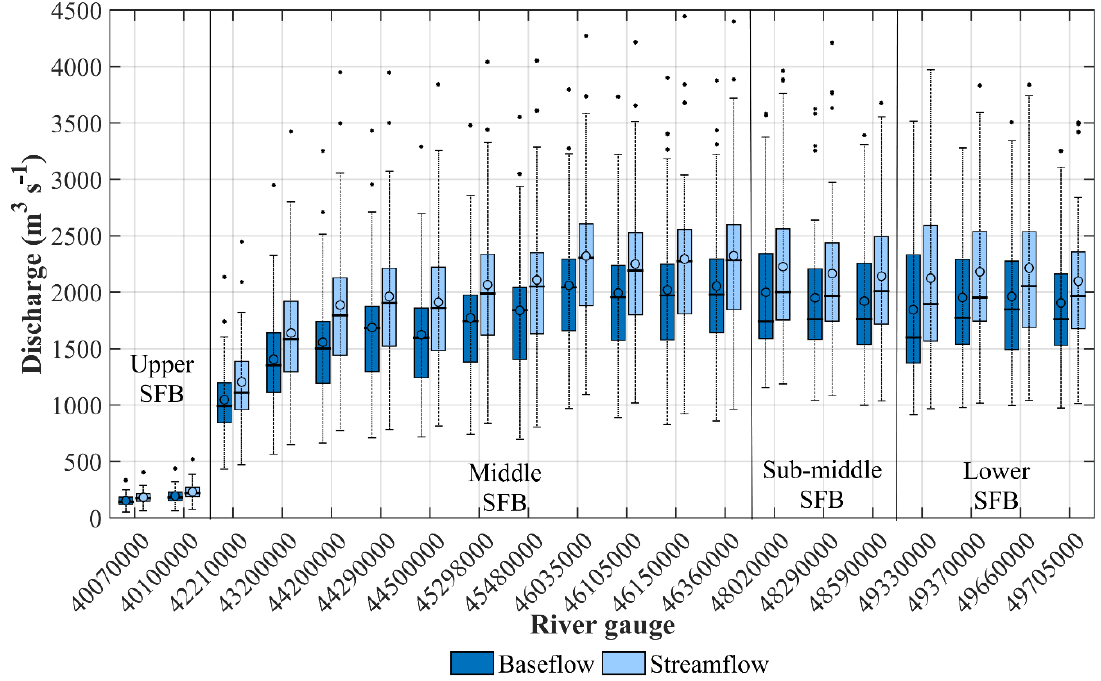
Figure 3. Boxplot of the baseflow and streamflow of Sao Francisco River in the hydrographical regions (Upper, Middle, Sub-middle and Lower SFB) over the 1980–2015 period.